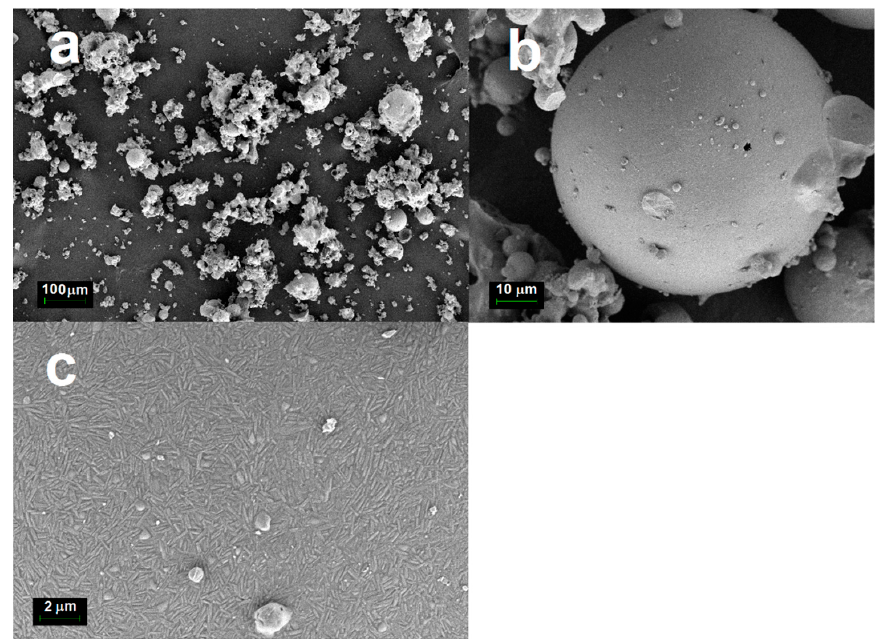
Figure 5. FESEM images showing the ( a ) size distribution of the cenospheres heated at 1200 °C and ( b ) single sphere and ( c ) outer surface of a sphere in closer views.